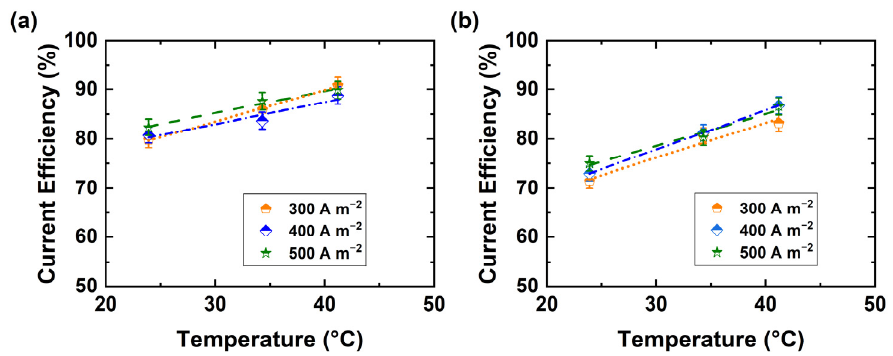
Figure 6. Current efficiency of BPED products in a stack of 10 repeating units at different current densities of ( a ) NaOH (0.5 ± 0.01 M), and ( b ) H 2 SO 4 (0.25 ± 0.01 M).